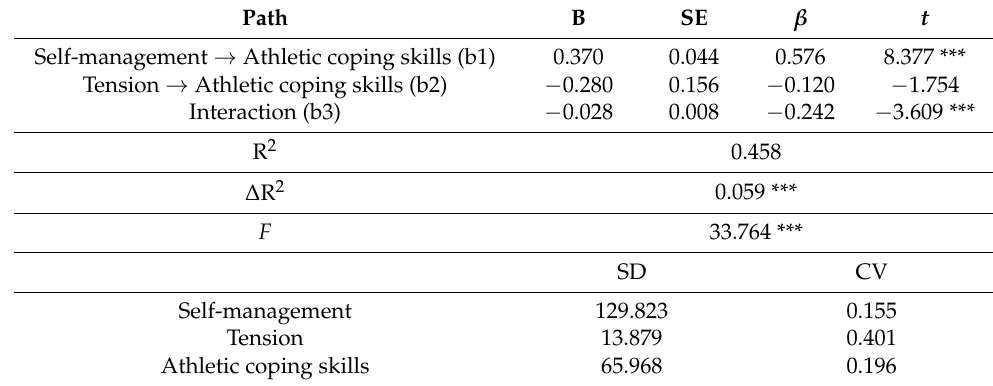
Table 5. Analysis of the moderating effect of tension on athletes’ self-management and sports coping skills. Path B SE β t Self-management → Athletic coping skills (b1) 0.370 0.044 0.576 Tension → Athletic coping skills